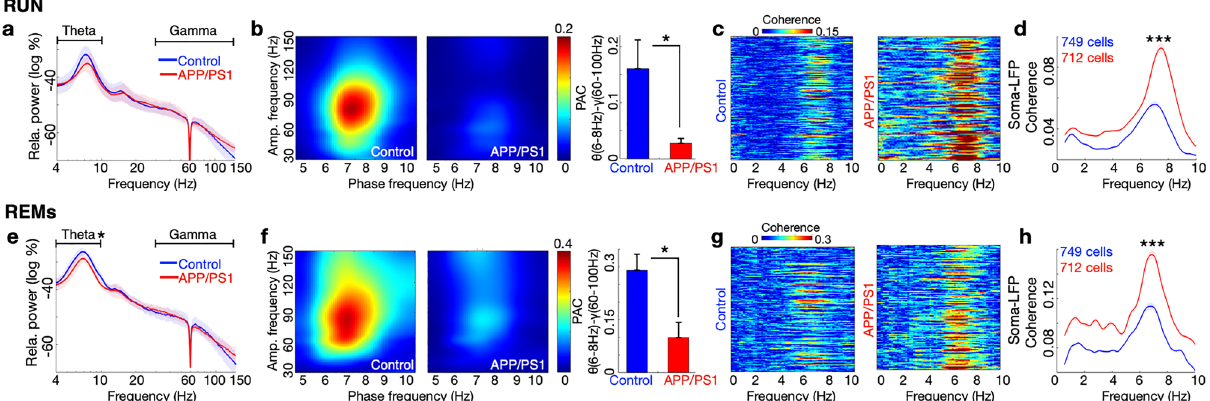
Figure 3. Aβ impairs hippocampal theta–gamma coupling in RUN and REM sleep and is associated with aberrant synchronization of neurons. ( a ) In RUN, LFP power in the theta and gamma bands in hippocampal CA1 were similar in control and APP/PS1 mice. ( b ) Phase-amplitude coupling (PAC) of theta (6–8 Hz)— gamma (60–100 Hz) was reduced in APP/PS1 mice compared to control mice. ( c ) Examples of coherence of each cell’s calcium trace with the LFP from one control mouse (146 cells) and one APP/PS1 mouse (124 cells) showed high coherence in the theta range during RUN. ( d ) Coherence of the neuronal calcium trace with the LFP in RUN was increased in the theta band in both control and APP/PS1 mice. This coherence was greater in APP/PS1 mice. ( e ) In REM sleep (REMs), LFP theta power was reduced in APP/PS1 mice compared to control, while gamma power was similar across the genotypes. ( f ), PAC of theta (6–8 Hz)–gamma (60–100 Hz) was reduced in APP/PS1 compared to control mice. ( g ) Coherence of each neuron’s calcium trace with the LFP in a control mouse (130 cells, left) and an APP/PS1 mouse (122 cells, right) showed high coherence in the theta range. ( h ) Coherence of the neuronal calcium trace with the LFP in REMs was increased in the theta band across genotypes and was greater in APP/PS1 than control mice. * p < 0.05; *** p < 0.001, 2-sided t-tests. Control n = 6 mice, APP/PS1 n = 7 mice. Data are smoothed with a Gaussian window (σ = 2 Hz) for display purposes. Data are represented as mean ±